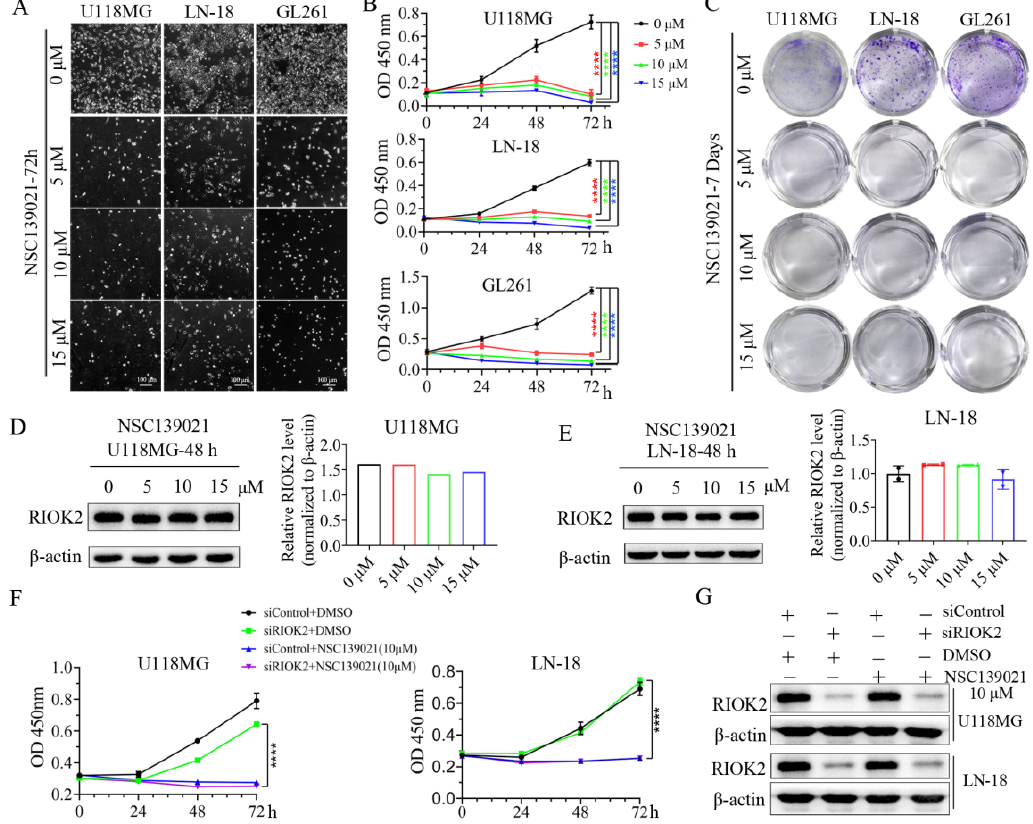
Figure 1. NSC139021 inhibited the proliferation of glioblastoma cells independently on RIOK2. ( A ) Cell proliferation was inhibited after NSC139021 (5, 10, 15 μ M) treatment for 72 h in U118MG, LN-18, and GL261 cells. ( B ) CCK-8 assays showed that cell viabilities were decreased after NSC139021 (5, 10, 15 µ M) treatment for 48 h or 72 h in U118MG, LN-18, and GL261 cells. ( C ) Colony formation assays also indicated that colony numbers were decreased after NSC139021 (5, 10, 15 µ M) treatment for 10–14 days in U118MG, LN-18, and GL261 cells. ( D , E ) RIOK2 protein level in U118MG and LN-18 cells after treatment with NSC139021 and was quantified and normalized to β -actin and plotted on the right panel. ( F ) CCK-8 assays demonstrated that neither cell viabilities nor the inhibitory effects of NSC139021 (10 µ M) on proliferation were affected by siRIOK2 in U118MG and LN-18 cells. ( G ) Western blot analysis showed that RIOK2 was reduced by siRIOK2 interfering for 72 h but was not affected by NSC139021 (10 µ M) treatment for 48 h. **** p < 0.0001 when compared to the DMSO